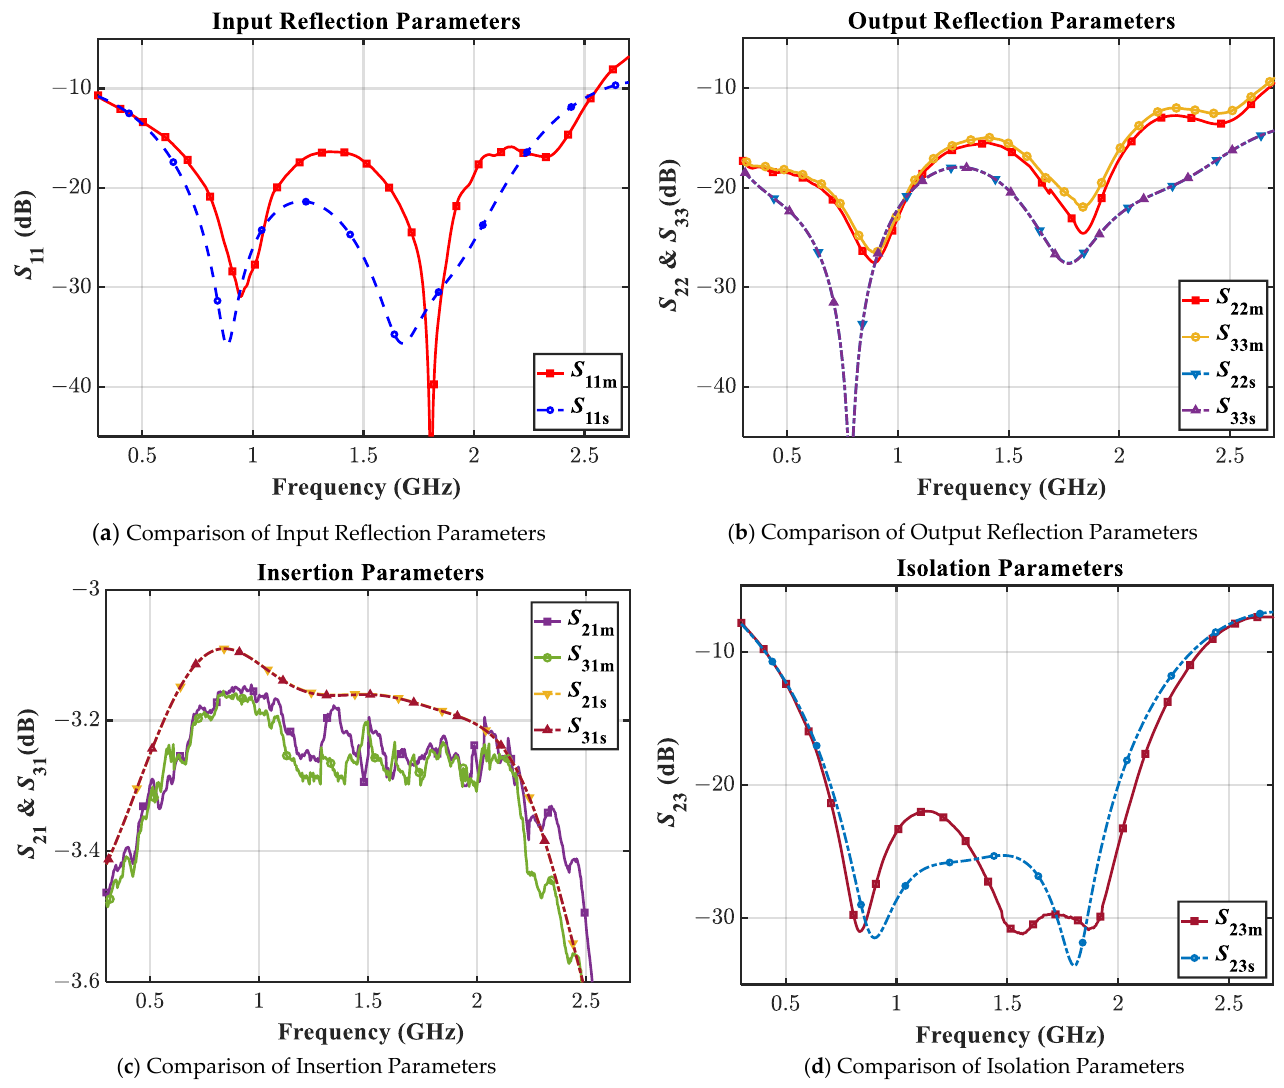
Figure 12. The EM simulated (subscript s) vs the measured (subscript m) magnitudes of S-parameters.